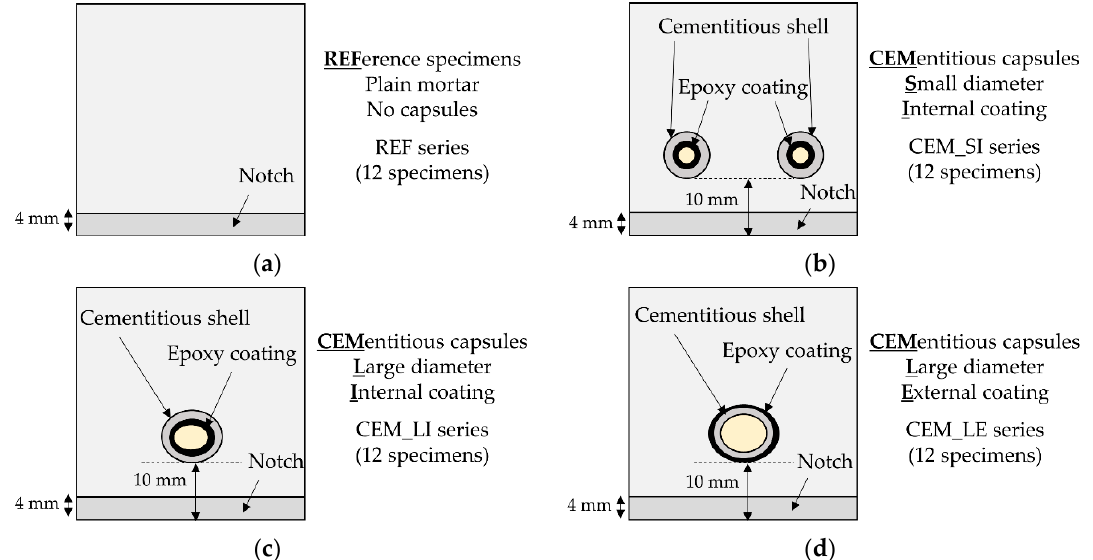
Figure 4. Schematic cross section of the specimens: ( a ) without capsules, REF series; ( b ) with two small-diameter capsules, CEM_SI series; ( c ) with one large-diameter capsule with internal epoxy coating, CEM_LI series; ( d ) with one-large diameter capsule with external epoxy coating, CEM_LE series.